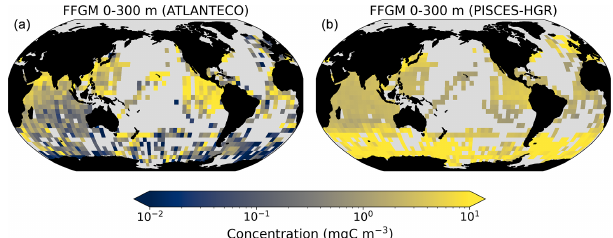
Figure A4. Comparison between AtlantECO-observed and PISCES-HGR-modeled FFGM biomasses. The color bars are in logarithmic scale. (a) Annual average of monthly observations of FFGM concentrations by AtlantECO on 5 ◦ resolution grid. (b) Annual average of monthly modeled FFGM concentrations by PISCES-HGR on 5 ◦ grid, masked for missing monthly observa- tions.